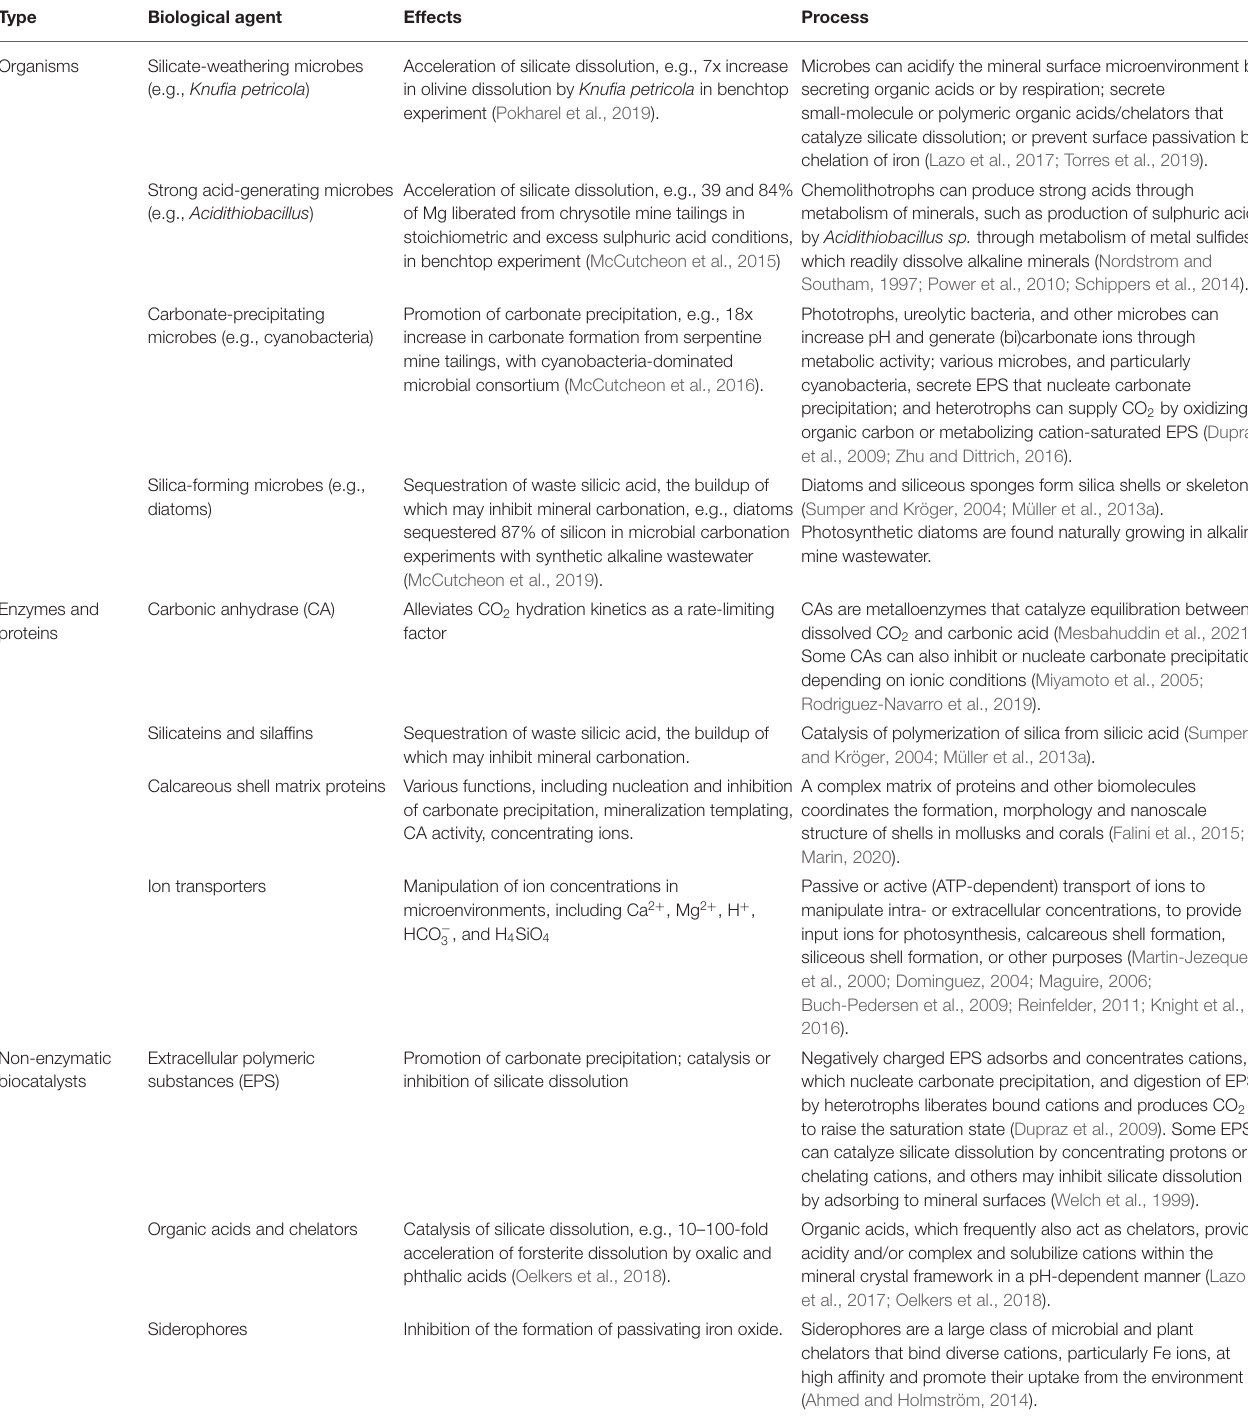
TABLE 4 | Influence of biological agents on reactions or ions underlying geochemical